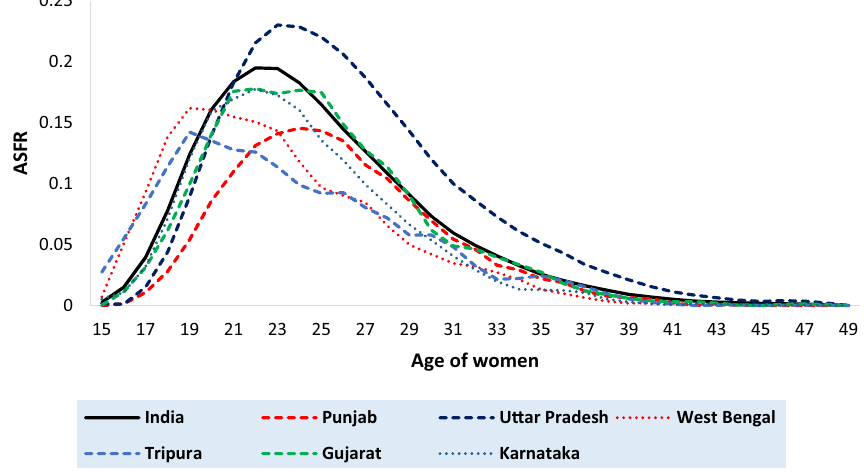
Figure 2. Age-specific fertility rate (ASFR) of India and the 6 selected states as per Fourth round of National Family Health Survey